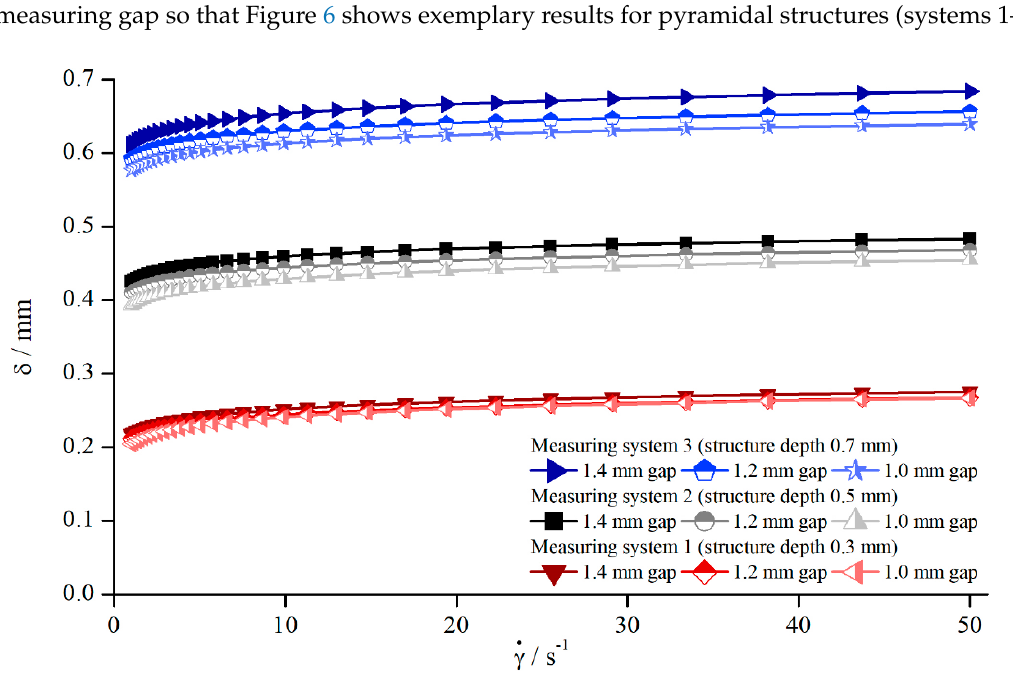
Figure 6. E ff ective gap extension δ dependent on shear rate for AK 5000, measured with di ff erent Figure 6. Effective gap extension 𝛿 dependent on shear rate for AK 5000, measured with different pyramidal structures (systems pyramidal structures (systems 1–3).